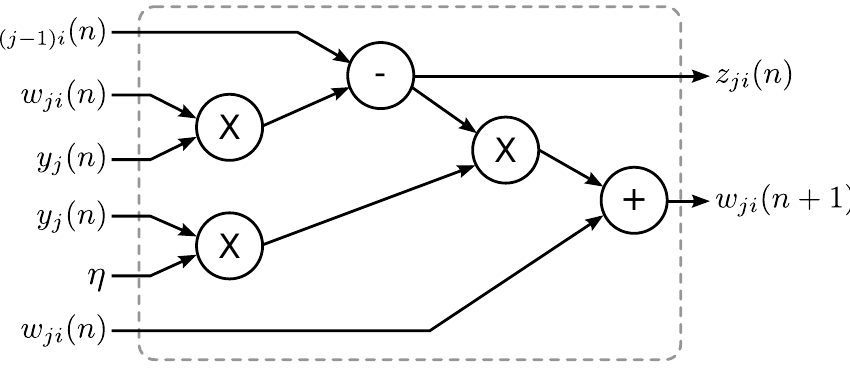
Figure 7. The hardware implementation of each module in the SWU unit of the GHA circuit for feature